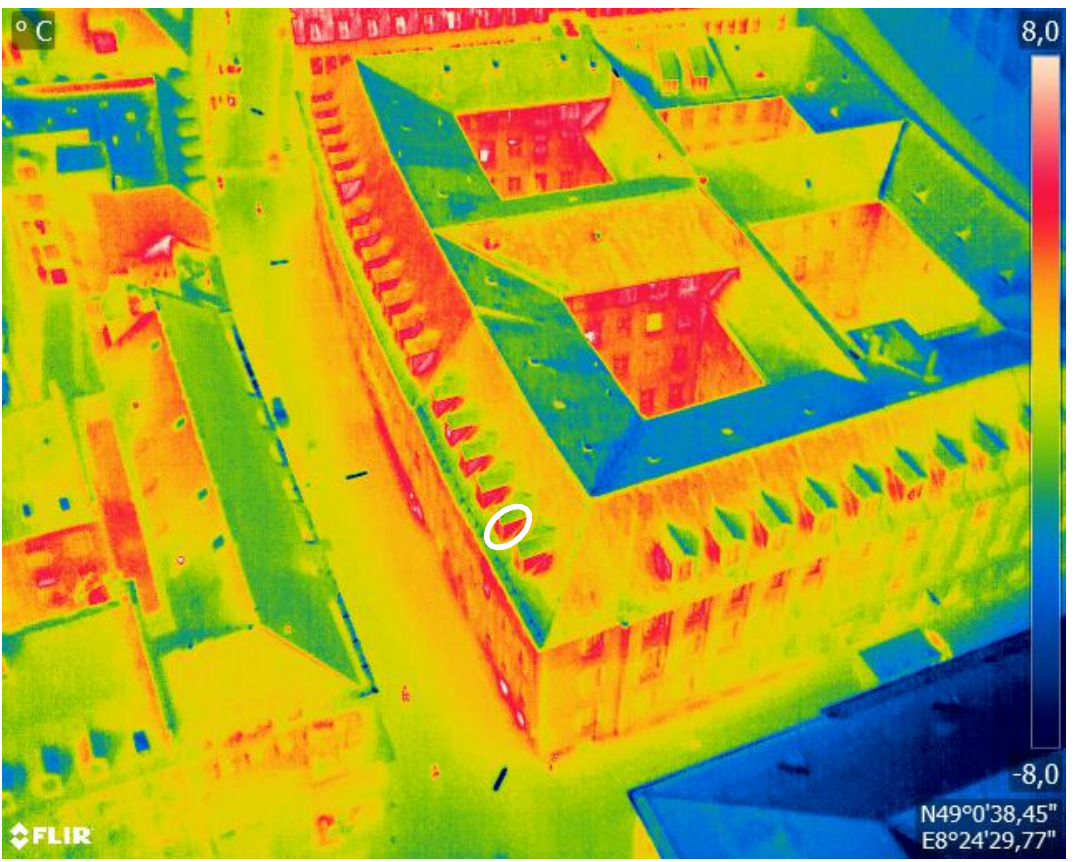
Figure A25. Example: thermal bridge of a dormer.